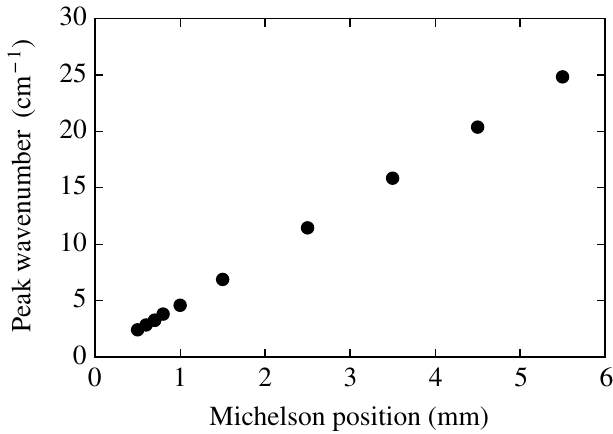
FIG. 6. Dependence of the peak terahertz emission frequency with the position of the Michelson mirror.